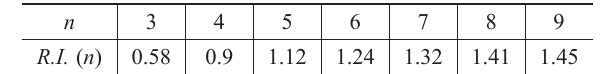
Table 7. Consistency index, R.I. , of random matrices (Golden et al. 1989) n 3